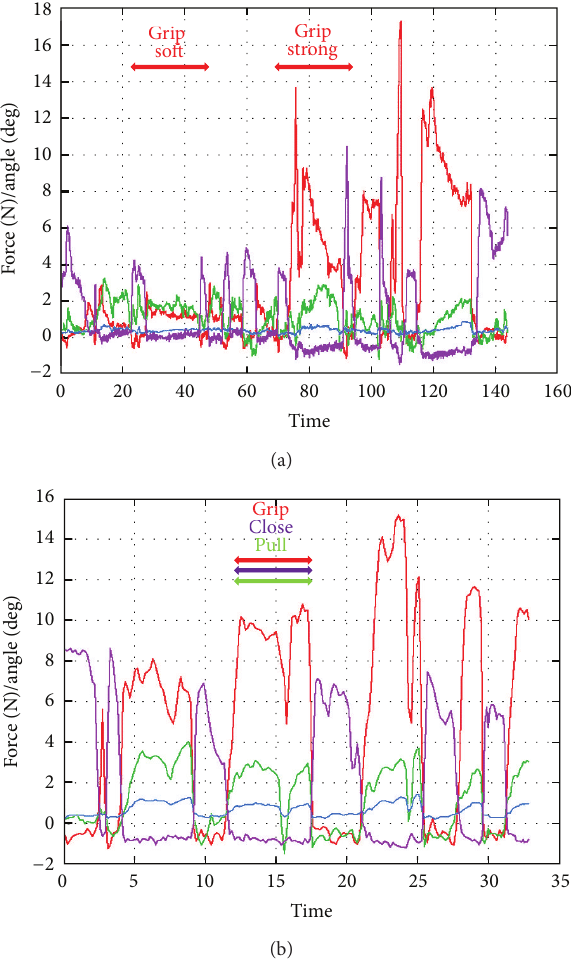
Figure 7: Experiment (B), grip the gonadal vein.